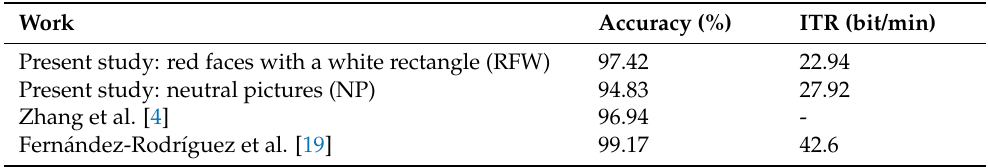
Table 2. Comparison of average performance for the conditions considered here and the results of other